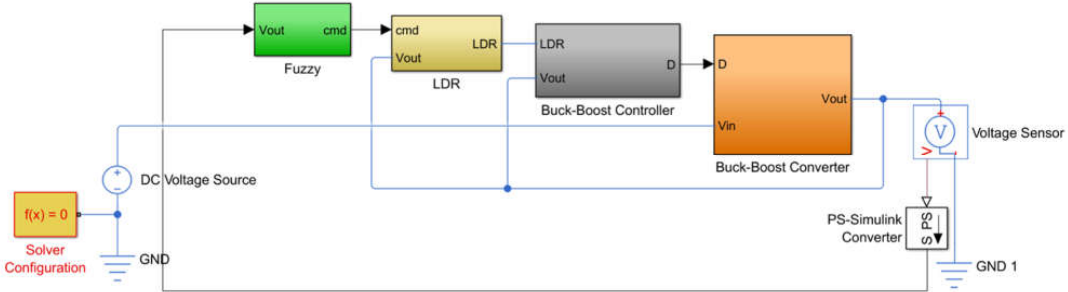
Figure 12. Circuit simulation model of the auto-ranging power converter system.